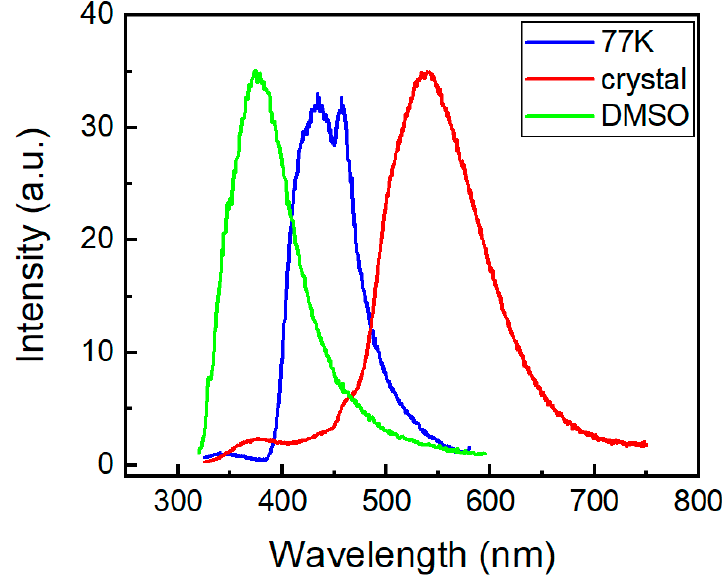
Figure 13b indicates that the HOMO is an antibonding orbital with respect to C-N and C-S bonds in the central ring, showing that there is a strong C-C bonding character, whereas the LUMO is mostly a non-bonding orbital in the center. Thus, the HOMO-LUMO excitation leads to much shorter and stronger C-N and C-S bonds in the S 1 excited state, but C-C bonds are becoming weaker (Figure S4). Figure 11. Phosphorescence spectrum of compound 2a in solid state excited at 300 nm.